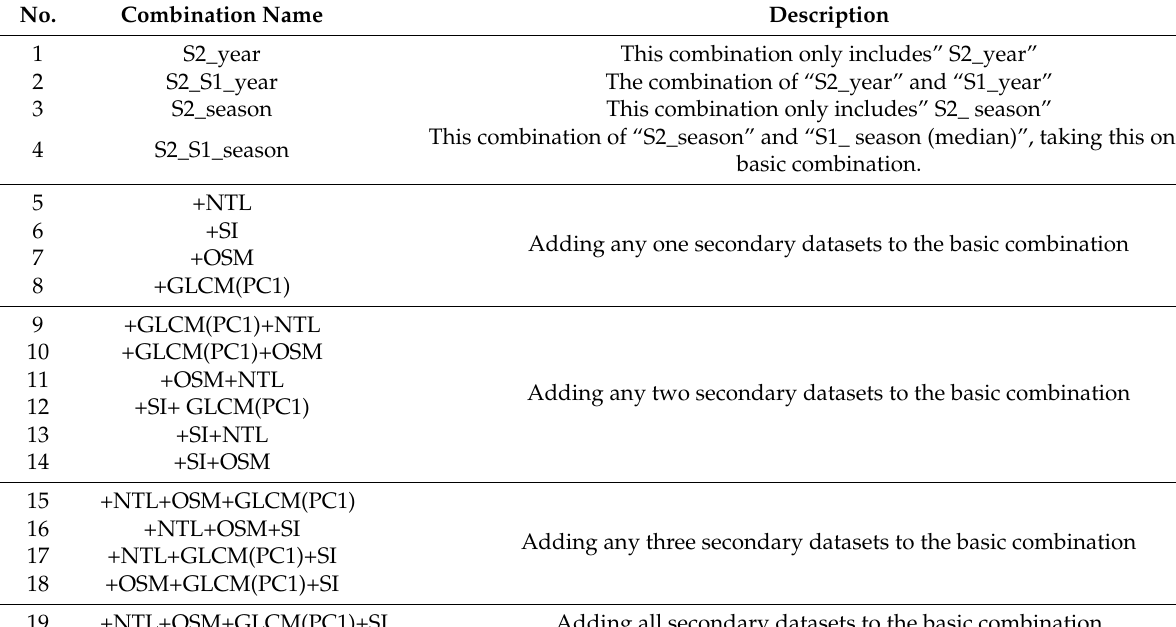
Table 3. The datasets in this